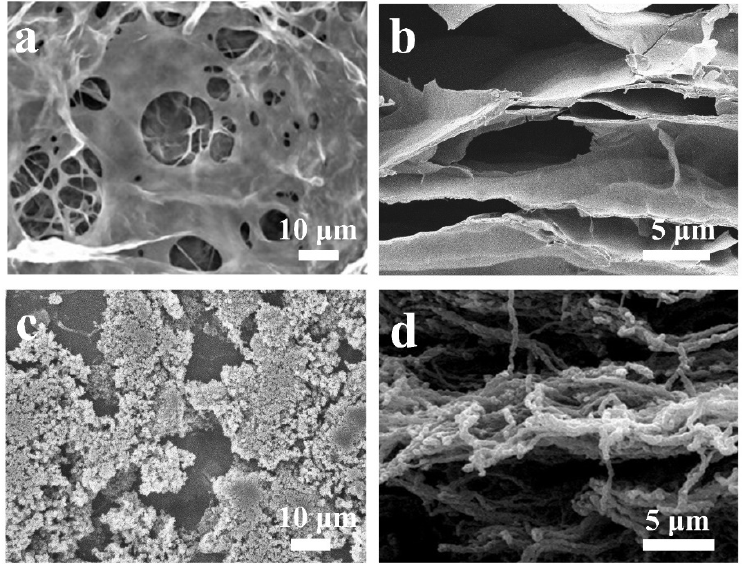
Figure 1. SEM images of ( a ) the surface; ( b ) cross section of MXene/CNF aerogel films; ( c ) the surface; ( d ) cross section of MXene/CNF–PANI aerogel films.